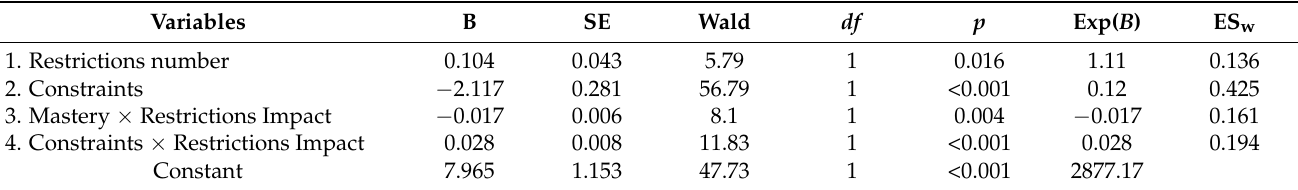
Table 2. Binary logistic regression final model for BDI (low, high).